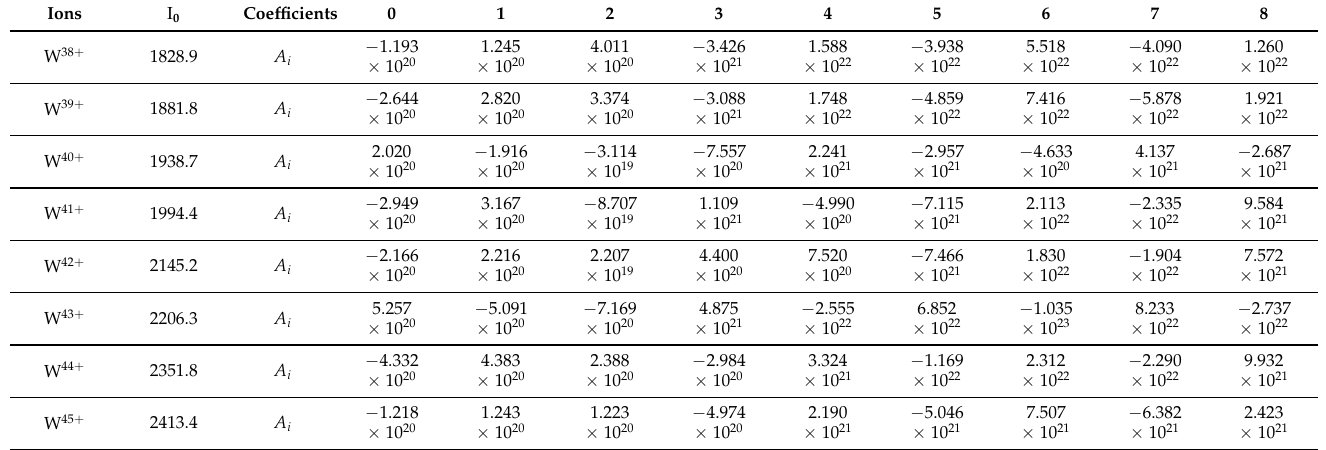
Table 5. Fitting coefficients for total EI